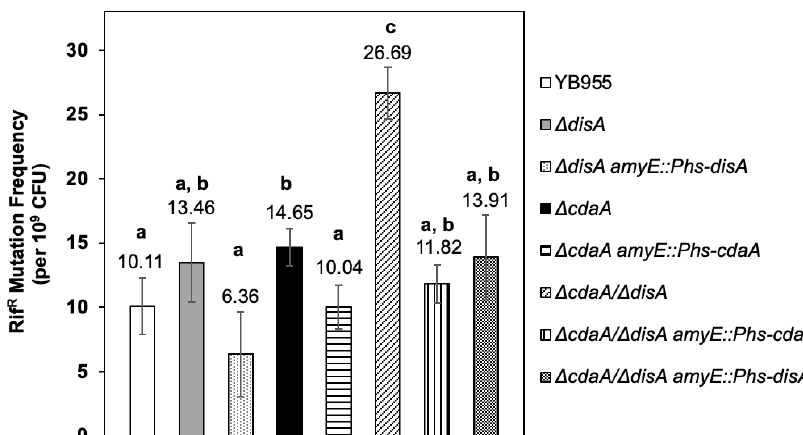
Figure 4. Mytomycin-C induced mutation frequencies to rifampicin resistance (Rif R ) of Bacillus subtilis YB955 (open bar), Δ disA (dark grey bar), Δ cdaA (black bar) and Δ cdaA /Δ disA (hatched bar) were determined during exponential growth. Complemented strains Δ disA amyE:: P hs-disA (light stippled bar), Δ cdaA amyE:: P hs-cdaA (horizontal striped bar), Δ cdaA /Δ disA amyE:: P hs-cdaA (vertical striped bar) and Δ cdaA / Δ disA amyE:: P hs-disA (dark stippled bar), were also tested. Data show the average from three independent experiments, each one by sextuplicate ± standard deviations. All strains were supplemented with IPTG 0.25 mM. Different letters (a, b, c) represent significant statistical differences between means, the same letter denotes no significant difference, two letters in the same bar (a, b) mean statistically equal to both, group a and group b, as determined by a one-way ANOVA and multiple mean comparison by Tukey HSD test (all p -values < 0.05).